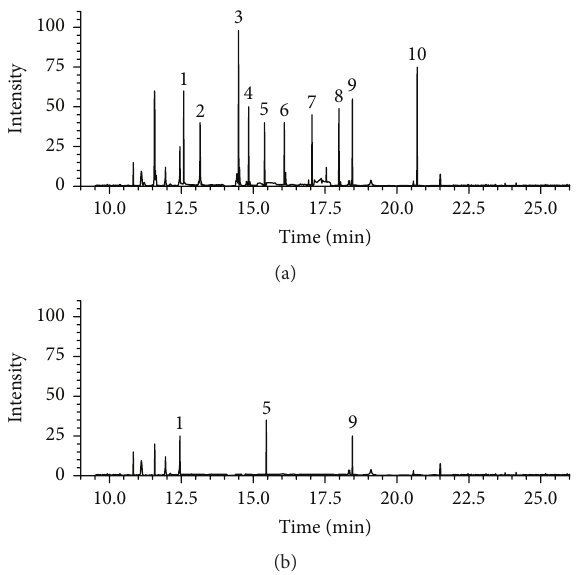
Figure 5: (a) Chromatogram of pesticides GC/MS analysis using HF-LPME extraction. Extraction for 30 minutes in aqueous donor solution spiked at 50.0 𝜇 g L −1 ; stirring speed 200 rpm; and